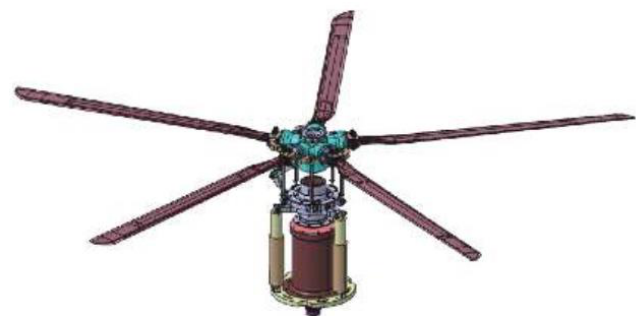
Figure 6. The Ф 3m tail-supported helicopter rotor model wind tunnel test rig.